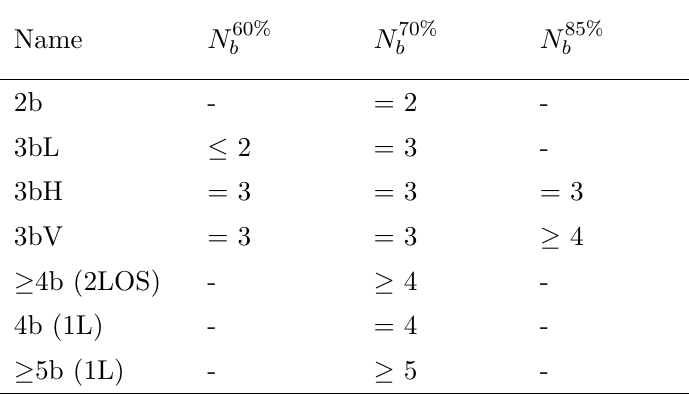
, N 70% and N 85% are defined as the b b b